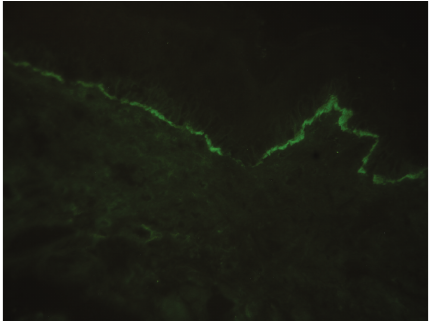
Figure 3: Direct immunofluorescence showed a linear band of IgG,